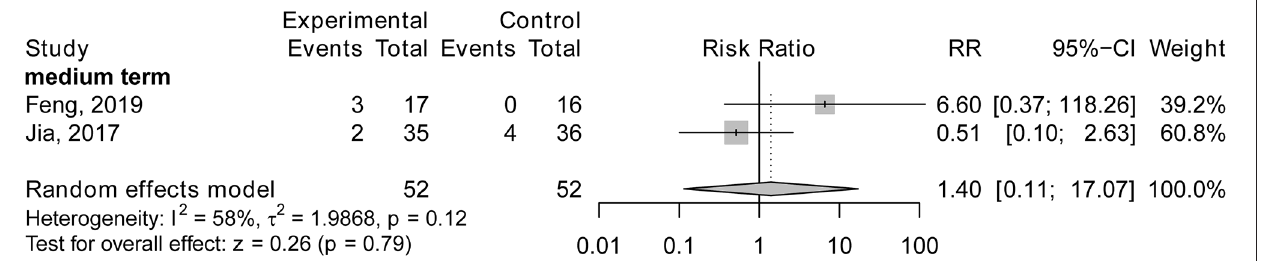
Frontiers in Aging Neuroscience |